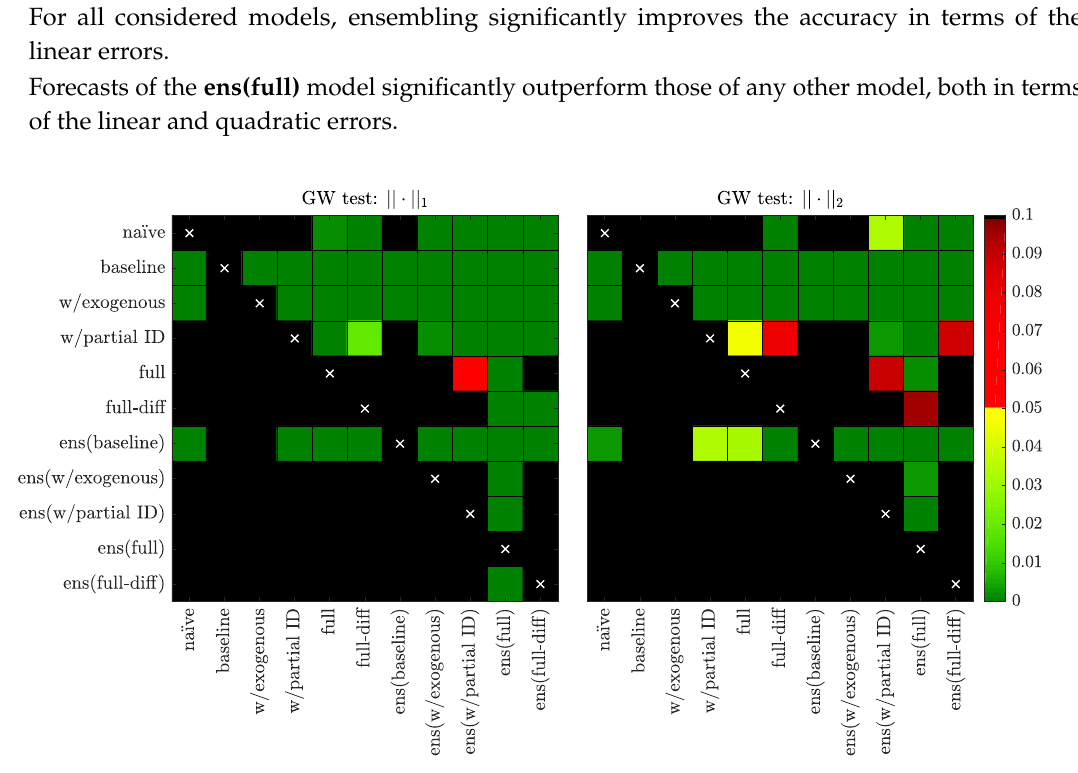
Figure 5. Results of the conditional predictive ability (CPA) test of Giacomini and White [16] for the linear ( left ) and quadratic ( right ) errors. We use a heat map to indicate the range of the p -values—the closer they are to zero ( dark green) the more significant is the difference between the forecasts of a → model on the X -axis (better) and the forecasts of a model on the Y -axis